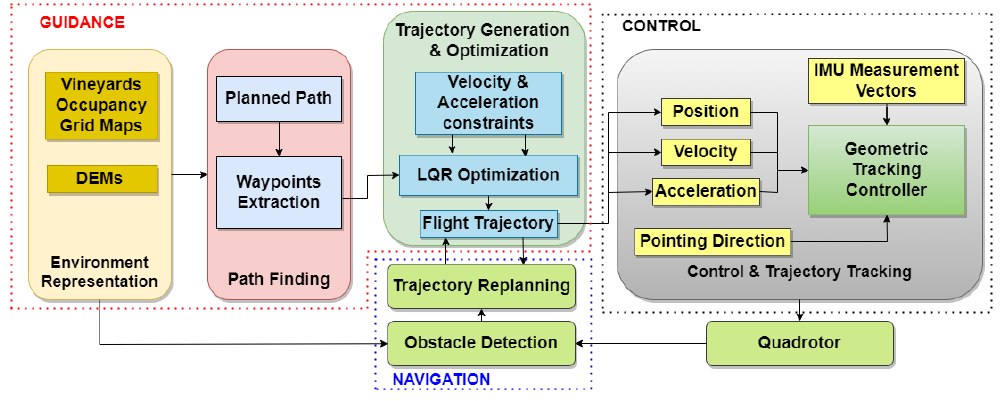
Figure 1. An overview of the GNC global